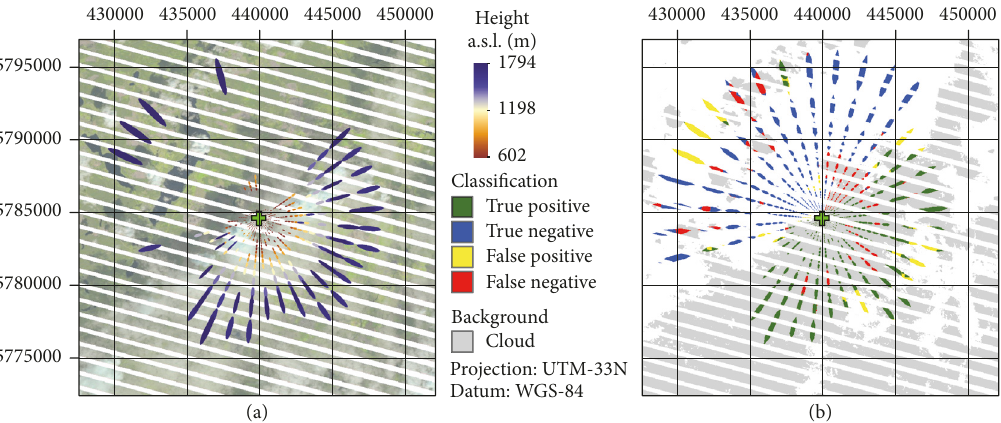
Figure 7: As Figure 5, but for 29 August 2011, 09:56 UTC.